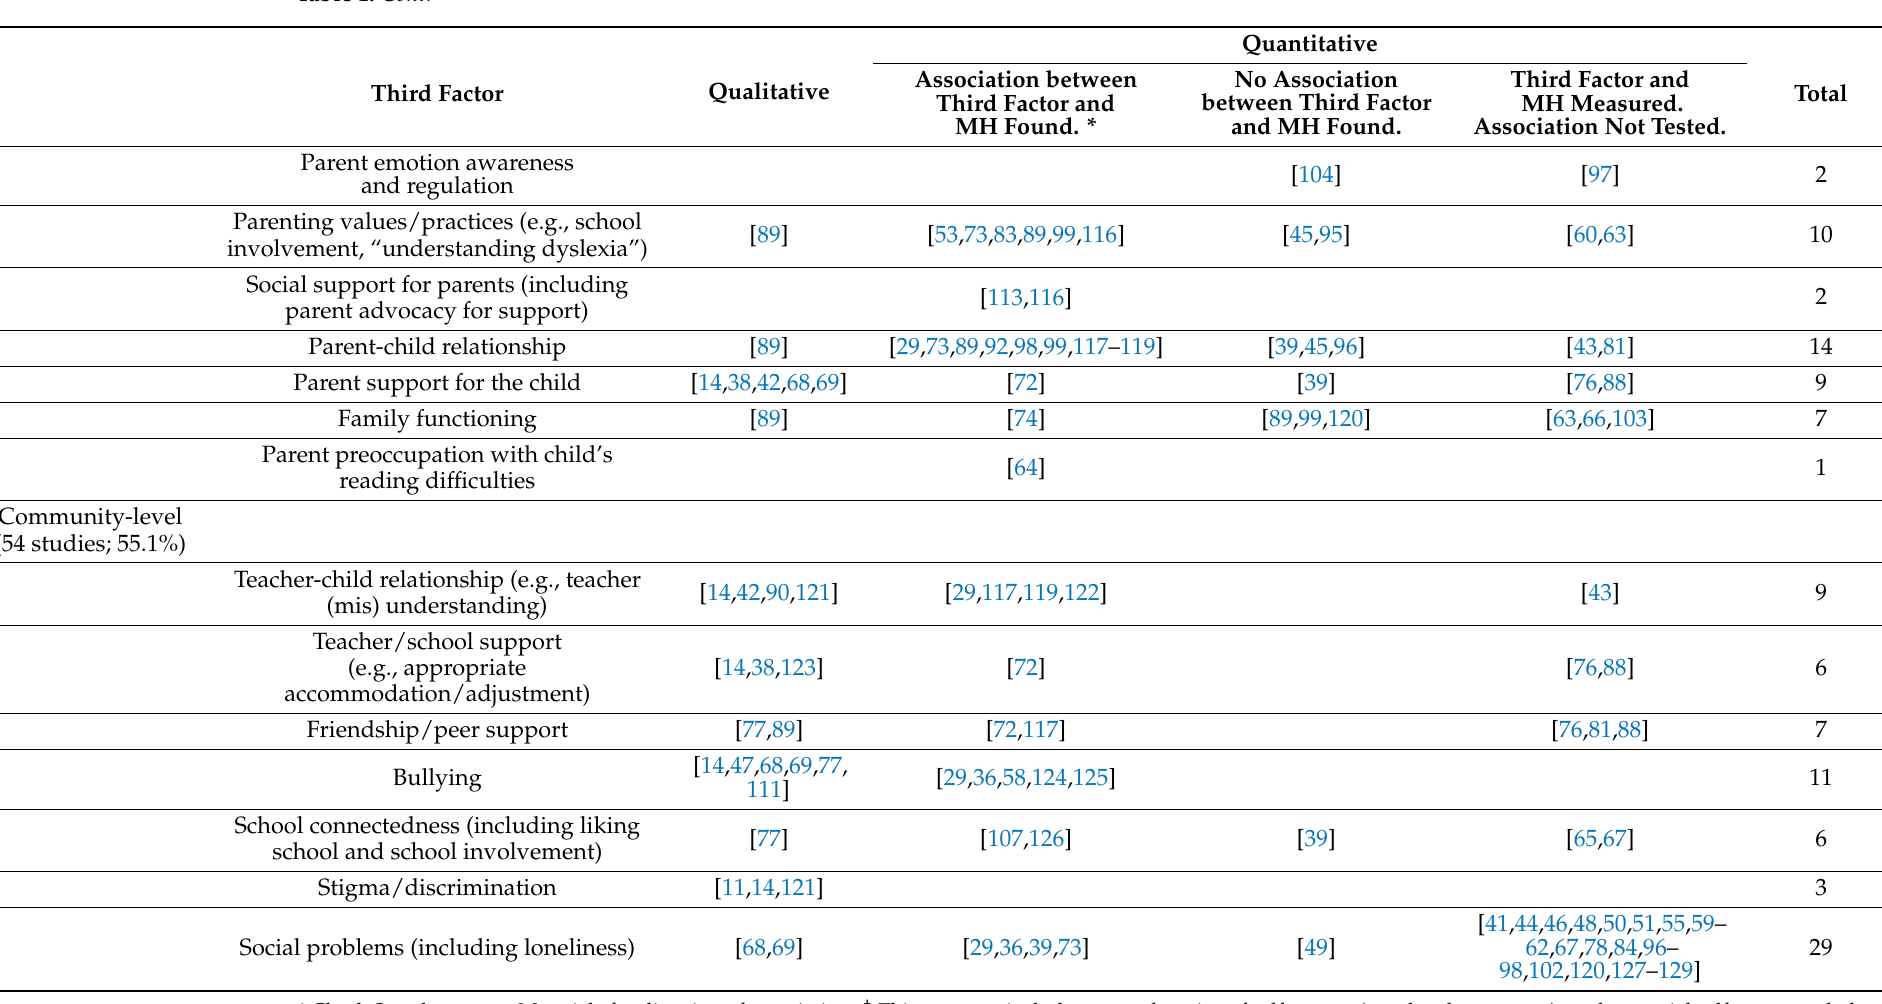
Table 1. Cont. Third Factor Qualitative